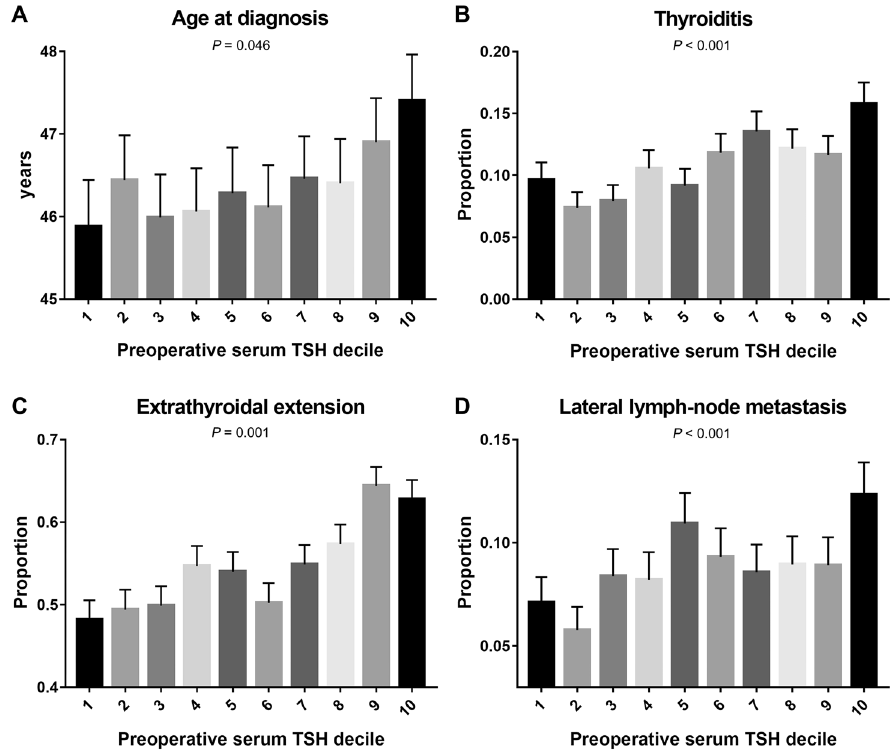
Figure 1. Pattern of prognostic marker of differentiated thyroid cancer according to preoperative serum TSH decile. ( A ) age, ( B ) presence of thyroiditis, ( C ) extrathyroidal extension, and ( D ) lateral lymph-node metastasis showed positive correlation with preoperative serum TSH